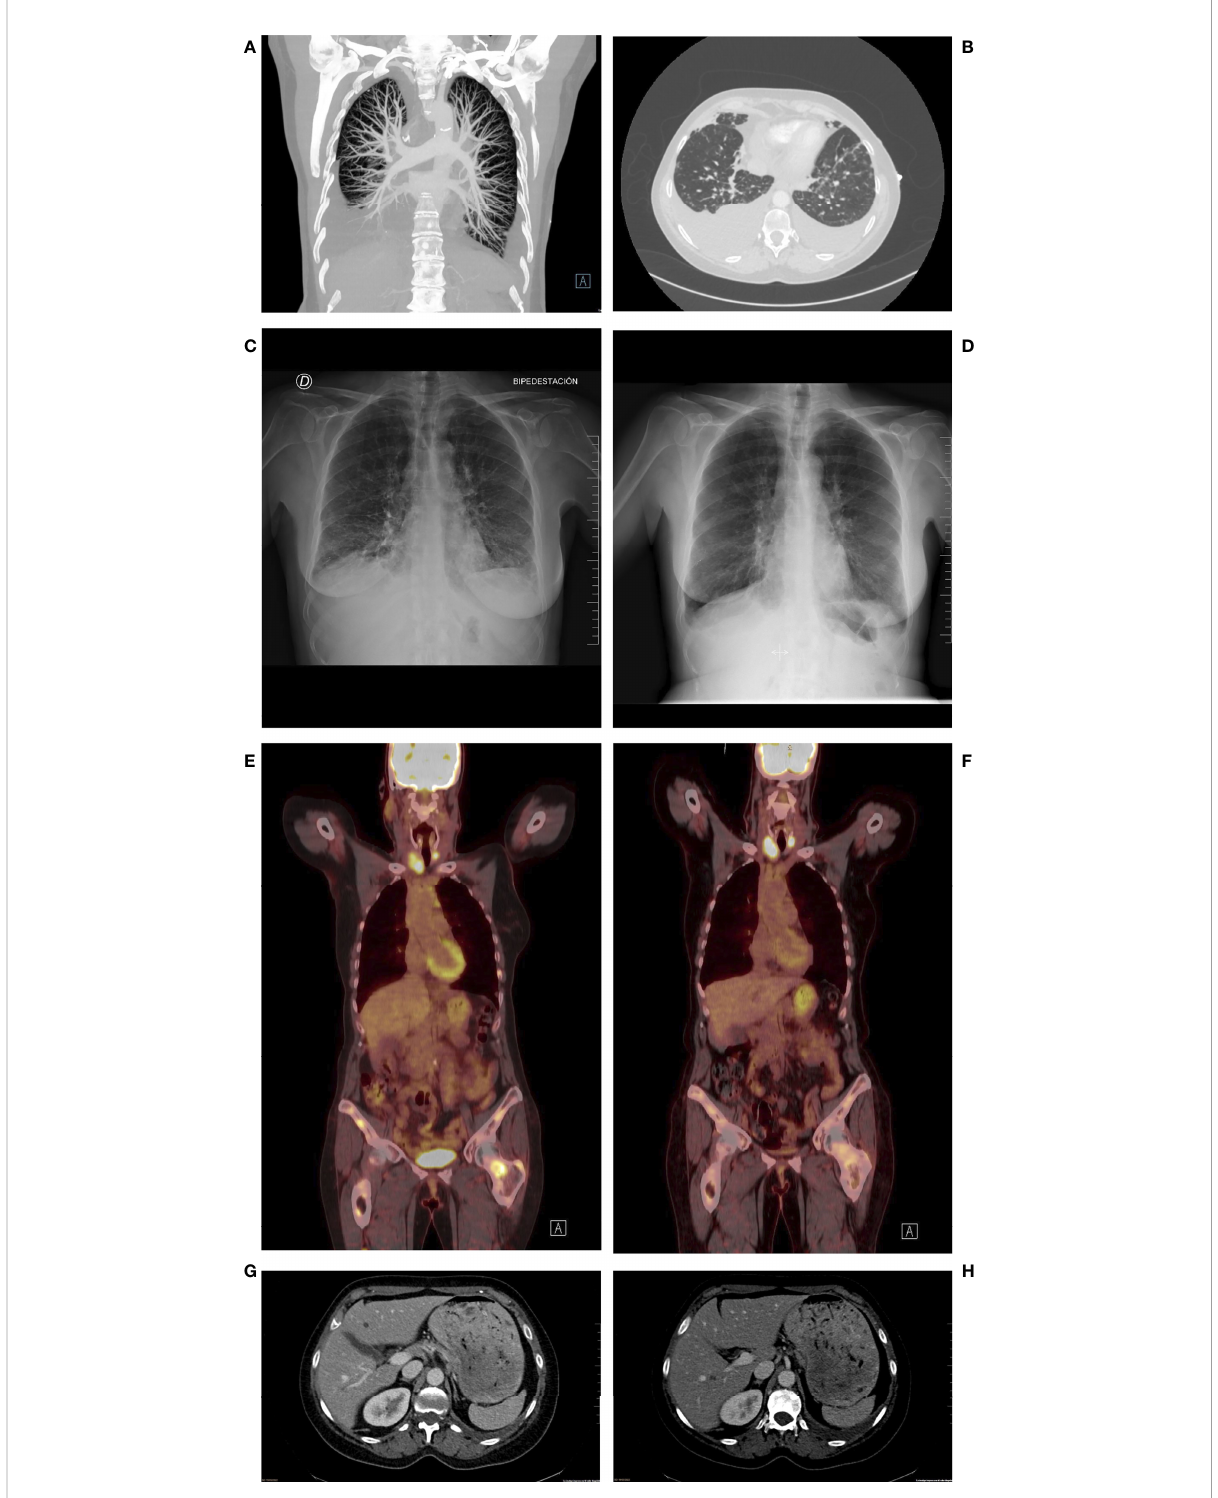
FIGURE 2 Representative images from the most relevant radiologic assessments. (A, B) CT Angiography at hospitalization showing signs of lymphangitis carcinomatosis. (C, D) Chest X-ray pre (C) and post (D) hospitalization showing the disappearance of lymphangitis signs and considerable reduction in pleural effusion. ( E, F) : PET/CT imaging at metastatic relapse diagnosis (E) and at fi rst reassessment (F) after fi rst-line treatment start, showing SUV reduction in metastatic sites. ( G, H) : CT scan at progression, showing two new hepatic lesions in the IV (G) and VI (H)